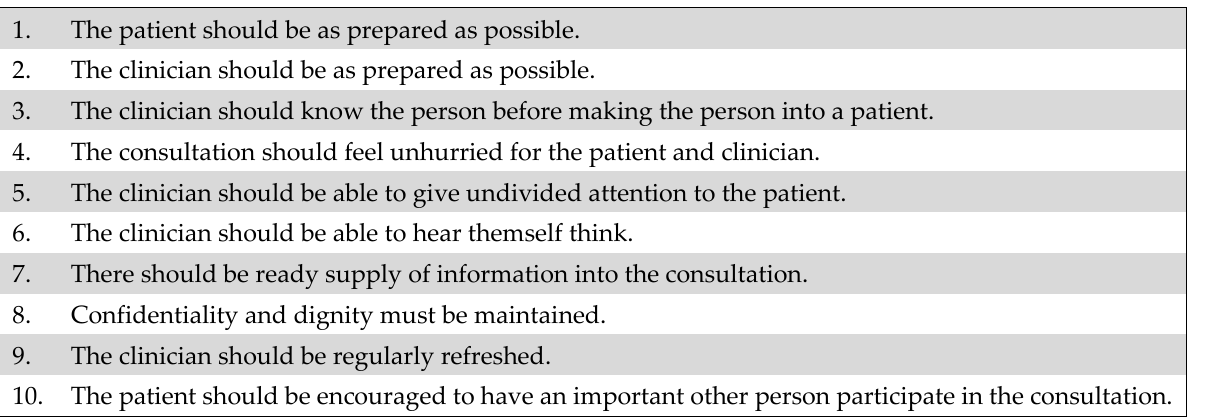
Figure 1. Ten quality indicators for clinical consultation [4].